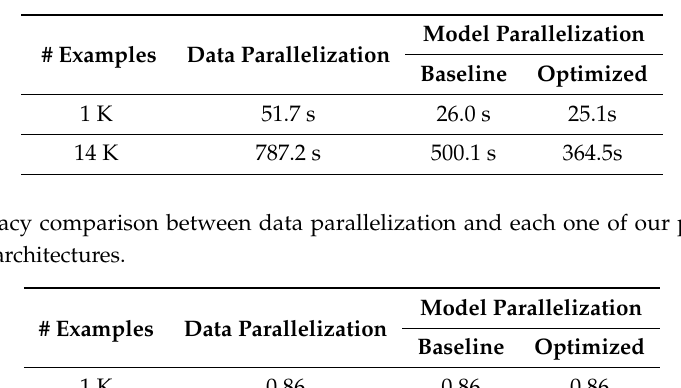
Table 4. Evaluation time comparison between the model parallelization and the ‘baseline’ and ‘optimized’ data parallelization schemes.